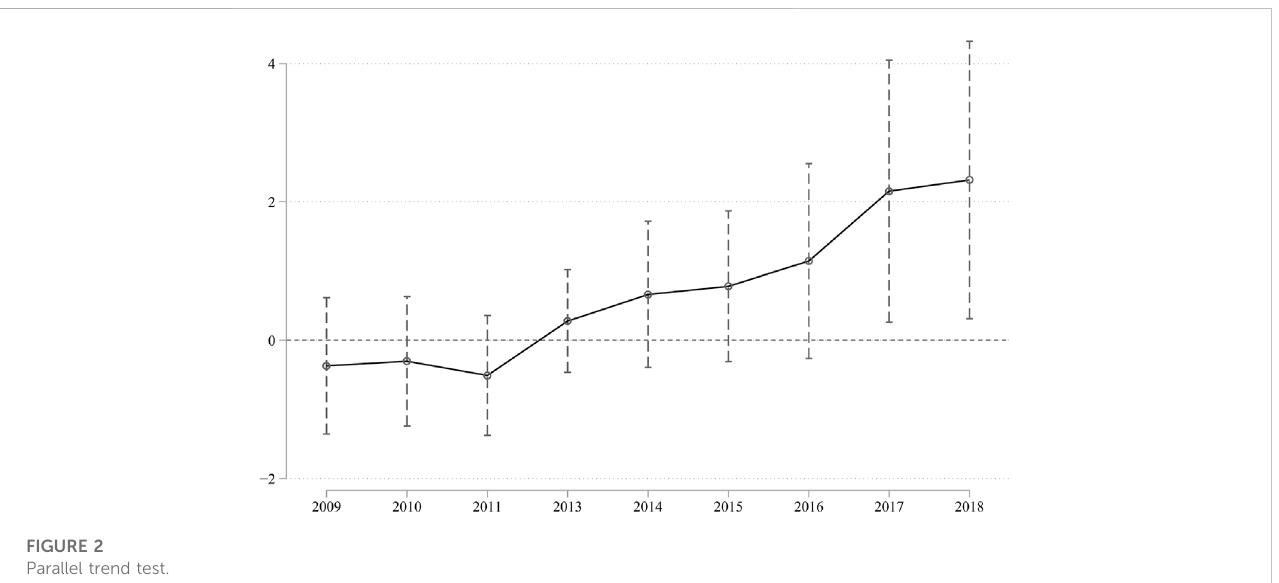
FIGURE 2 Parallel trend